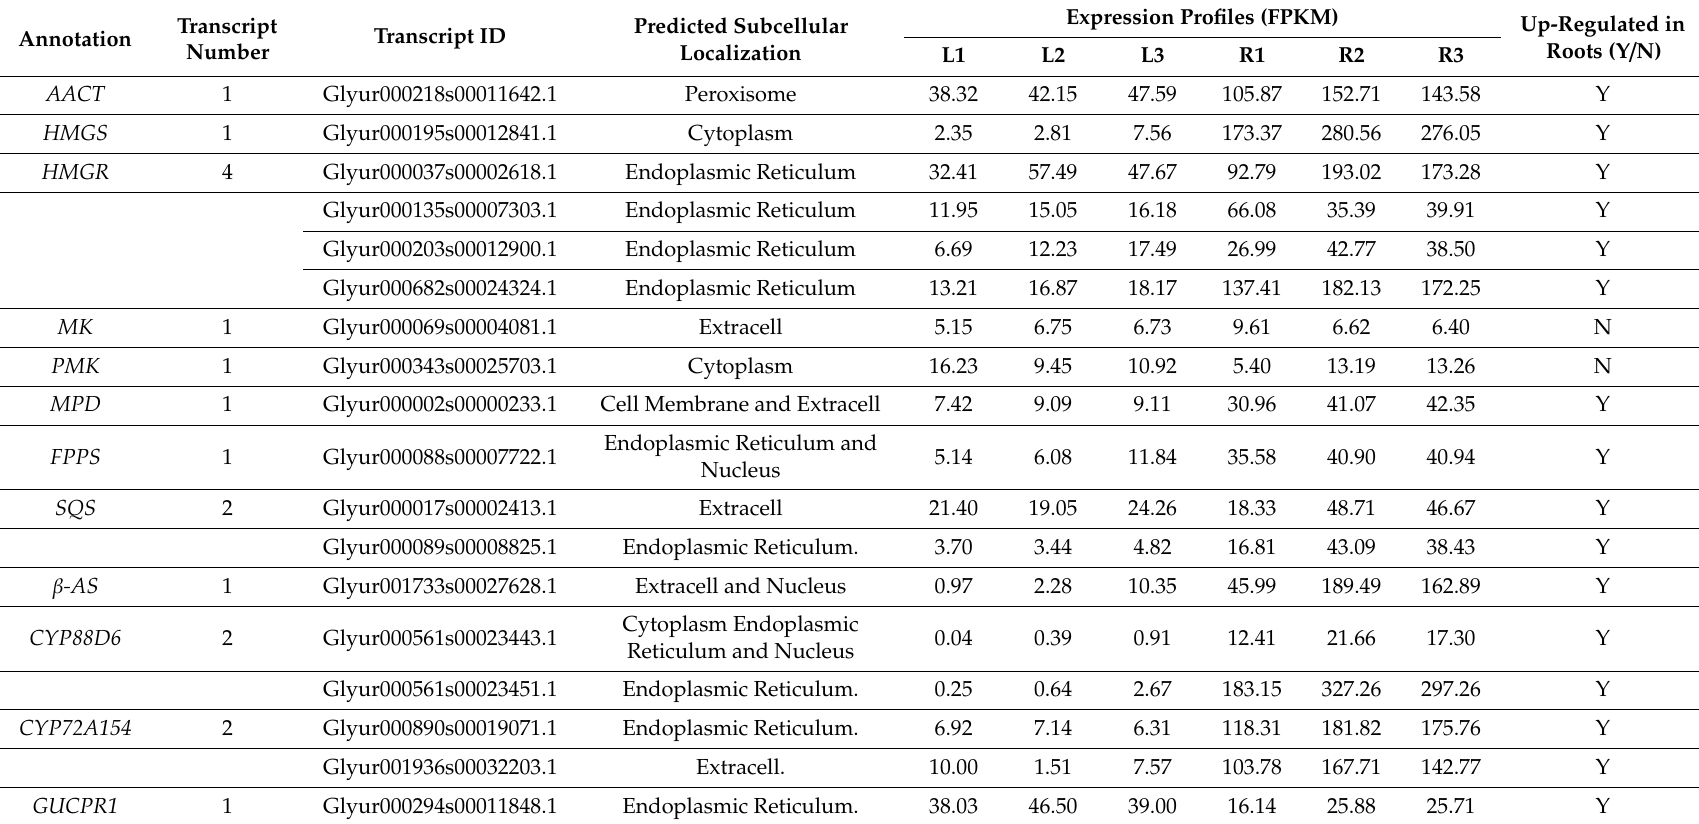
Table 1. Genes potentially involved in the GA biosynthetic